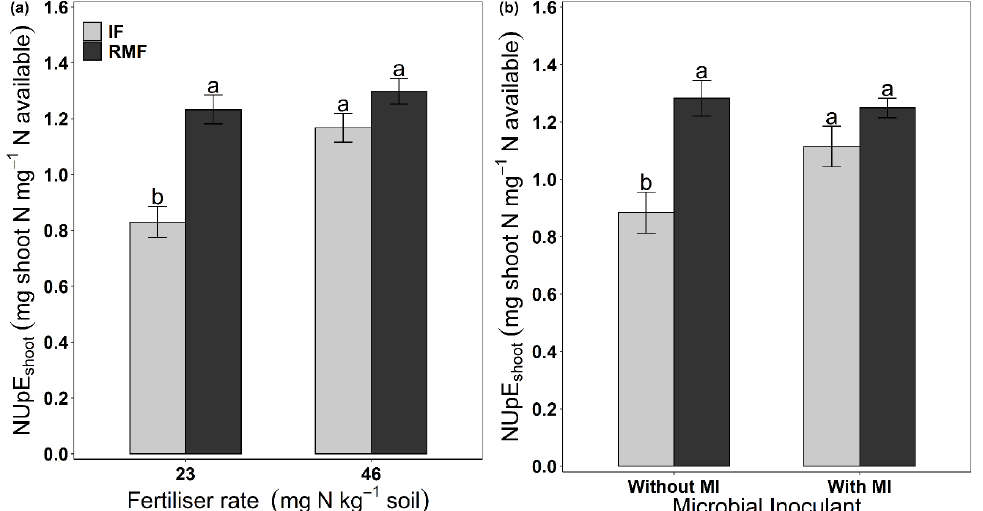
Figure 5. Shoot N uptake efficiency (NUpE shoot ) as influenced by the effect of ( a ) fertiliser type (Ft) × fertiliser rate (Fr) (mean ± SE, n = 8), and ( b ) Ft × microbial inoculant (MI) (mean ± SE, n = 8). In ( a ) and ( b ) separately, mean values followed by the same letter are not statistically different as per Tukey’s HSD test at p ≤ 0.05. Three-way ANOVA (Table 1) showed significant interaction of Ft × Fr ( p = 0.005) and Ft × MI ( p = 0.006) on NUpE shoot . IF, inorganic fertiliser; RMF, rock mineral fertiliser.